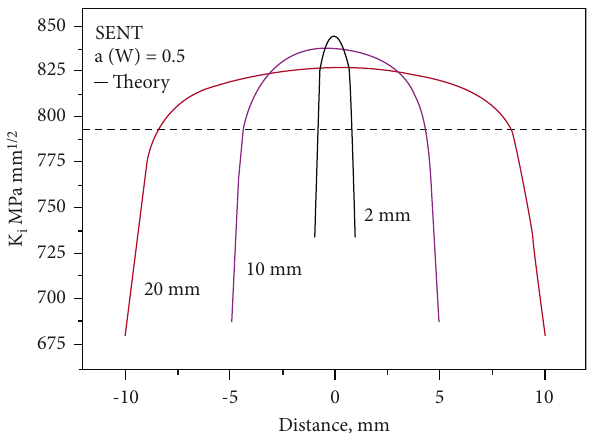
Figure 18: Values of tension intensity for different thicknesses based on source [33].